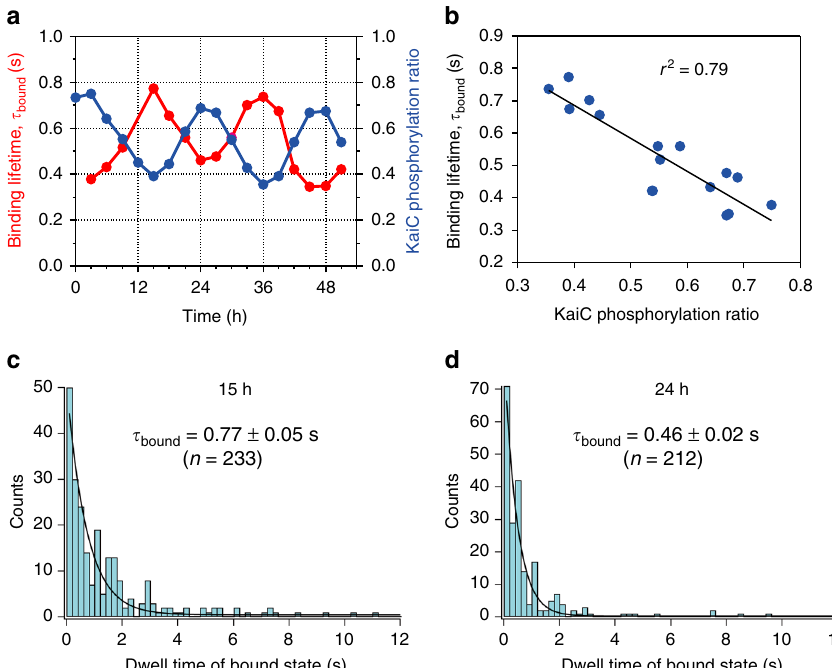
Fig. 4 KaiA ’ s af fi nity to KaiC oscillates with the KaiC phosphorylation rhythm in vitro. a KaiA ’ s bound state lifetime ( τ bound ) depends on KaiC WT phosphostatus over a 51-h time course of the in vitro cycle of phosphorylation. Puri fi ed KaiA (to a fi nal concentration of 1.9 μ M) was added to KaiC immobilized onto AP-mica and dynamics were observed by HS-AFM. See Supplementary Fig. 5 for dwell time data at each phase. Parallel samples were collected and immunoblotted to con fi rm KaiC phospho-status (blue) at each timepoint (Supplementary Fig. 6). KaiA – KaiC binding lifetime τ bound was calculated from the bound-state dwell time analysis (red). b Correlation between the extent of KaiC phosphorylation and KaiA ’ s bound state lifetime ( τ bound ). c , d Dwell time analysis of KaiA ’ s bound state lifetime c at the peak phase of phosphorylation cycle (24-h timepoint in a ) or d at the trough phosphorylation phase (15-h timepoint in a ). Dwell time analysis at each time point is shown in Supplementary Fig. 5, and a replicate experiment is shown in Supplementary Fig.